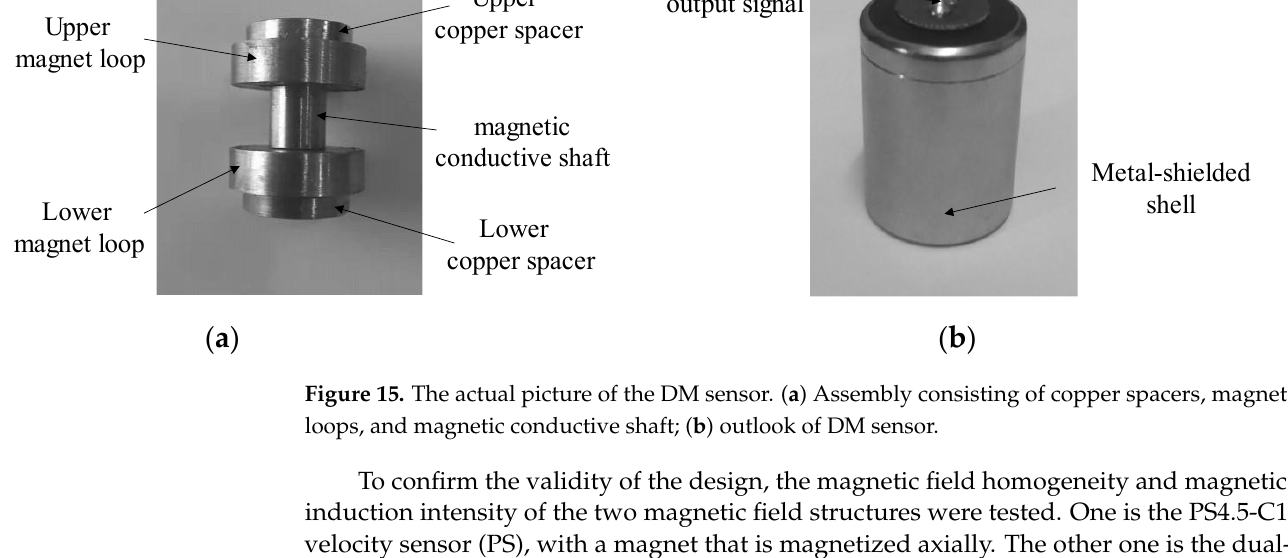
Figure 15. The actual picture of the DM sensor. ( a ) Assembly consisting of copper spacers, magnet loops, and magnetic conductive shaft; ( b ) outlook of DM sensor.